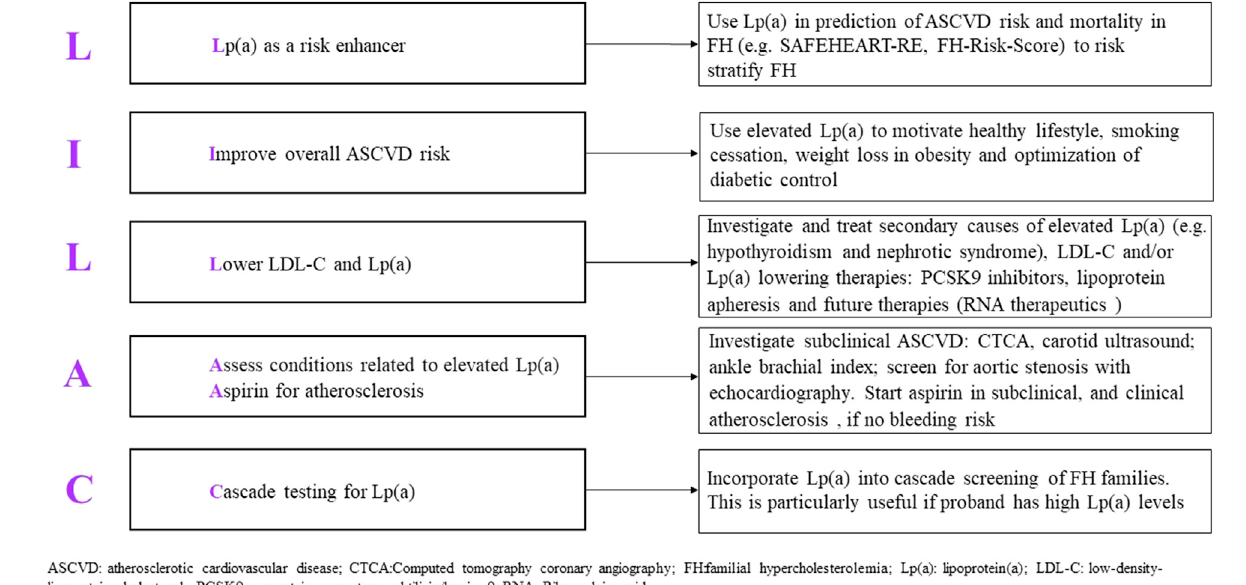
Frontiers in Genetics |